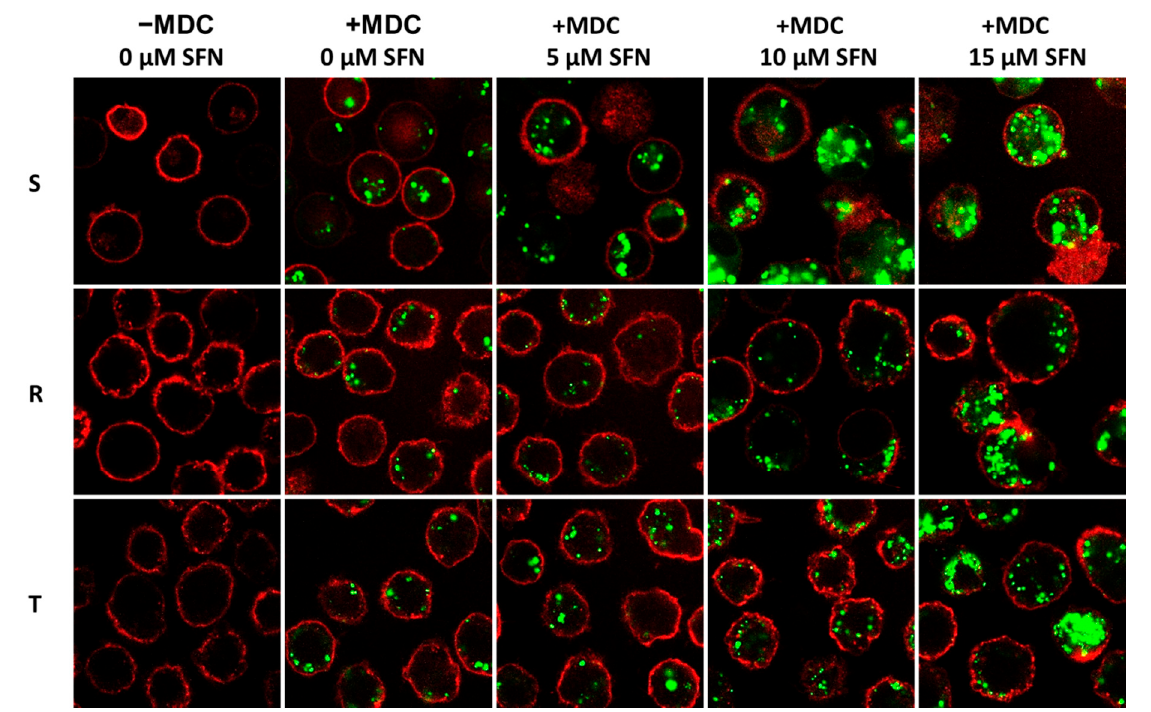
Figure 7. Autophagic vesicles after four passages of S, R and T cells in medium containing SFN at the indicated concentration were labeled MDC (green fluorescence). MDC was added in the presence of 500 nM TQR. The data are representative of three independent experiments. Wheat-germ agglutinin (WGA) conjugated with Alexa Fluor ™ 647 was used to label the cell surface. This lectin marks the surface of S, R and T cells [43,44] .